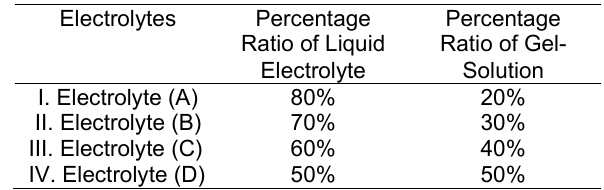
Figure 2. Steps of making TiO 2 slurry solution.